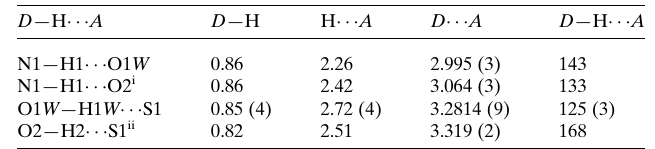
Table 1 Hydrogen-bond geometry (A˚ , (cid:3) ).